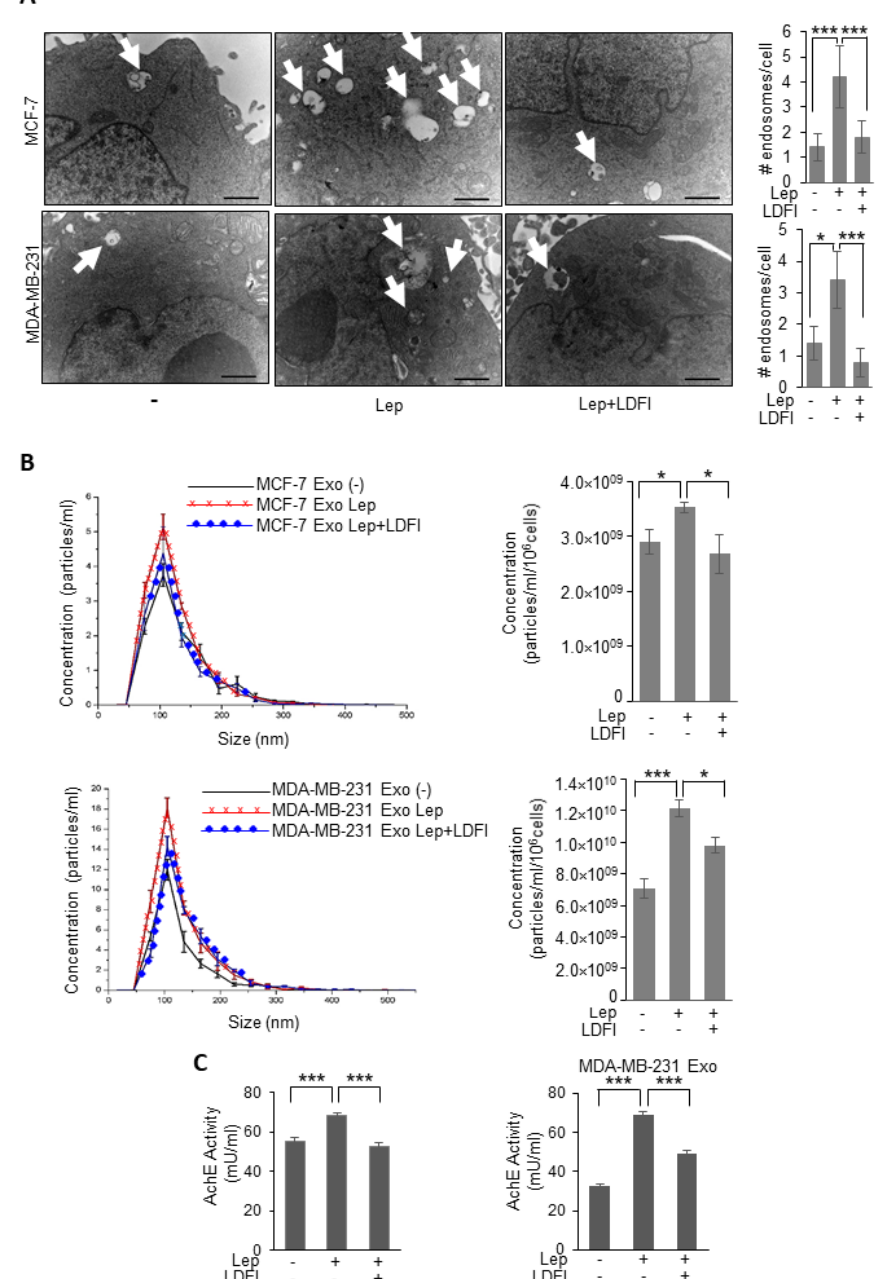
Figure 2. E ff ects of a selective leptin receptor antagonist (LDFI) on exosome release in breast cancer cells. ( A ) Representative images of transmission electron microscopy (TEM) showing fields of Multivesicular bodies (MVBs) in MCF-7 and MDA-MB-231 breast cancer cells treated with vehicle (-) Leptin (Lep, 500 ng/mL) alone or in combination with the leptin antagonist (LDFI, 1 μM) for 48 h. Scale bar 1 µ m. The histograms represent the mean ± S.D. of the MVB numbers in more than 15 fields per condition. ( B ) Representative size distribution profiles of exosomes (Exo), measured by nanoparticle tracking analysis, from conditioned media of MCF-7 and MDA-MB-231 breast cancer cells treated with vehicle (-) or Leptin (Lep, 500 ng/mL) alone or in combination with the leptin antagonist (LDFI, 1 µ M) for 48 h. The histograms represent the mean ± S.D. of exosome concentration (particles / mL / 10 6 cells) of two different experiments. ( C ) Concentration of exosomes released from MCF-7 and MDA-MB-231 breast cancer cells treated with vehicle (-), Leptin (Lep, 500 ng/mL) alone or in combination with the leptin antagonist (LDFI, 1 μM) for 48 h measured by acetylcholinesterase activity assay (AchE Activity). * p < 0.05, *** p < 0.001.